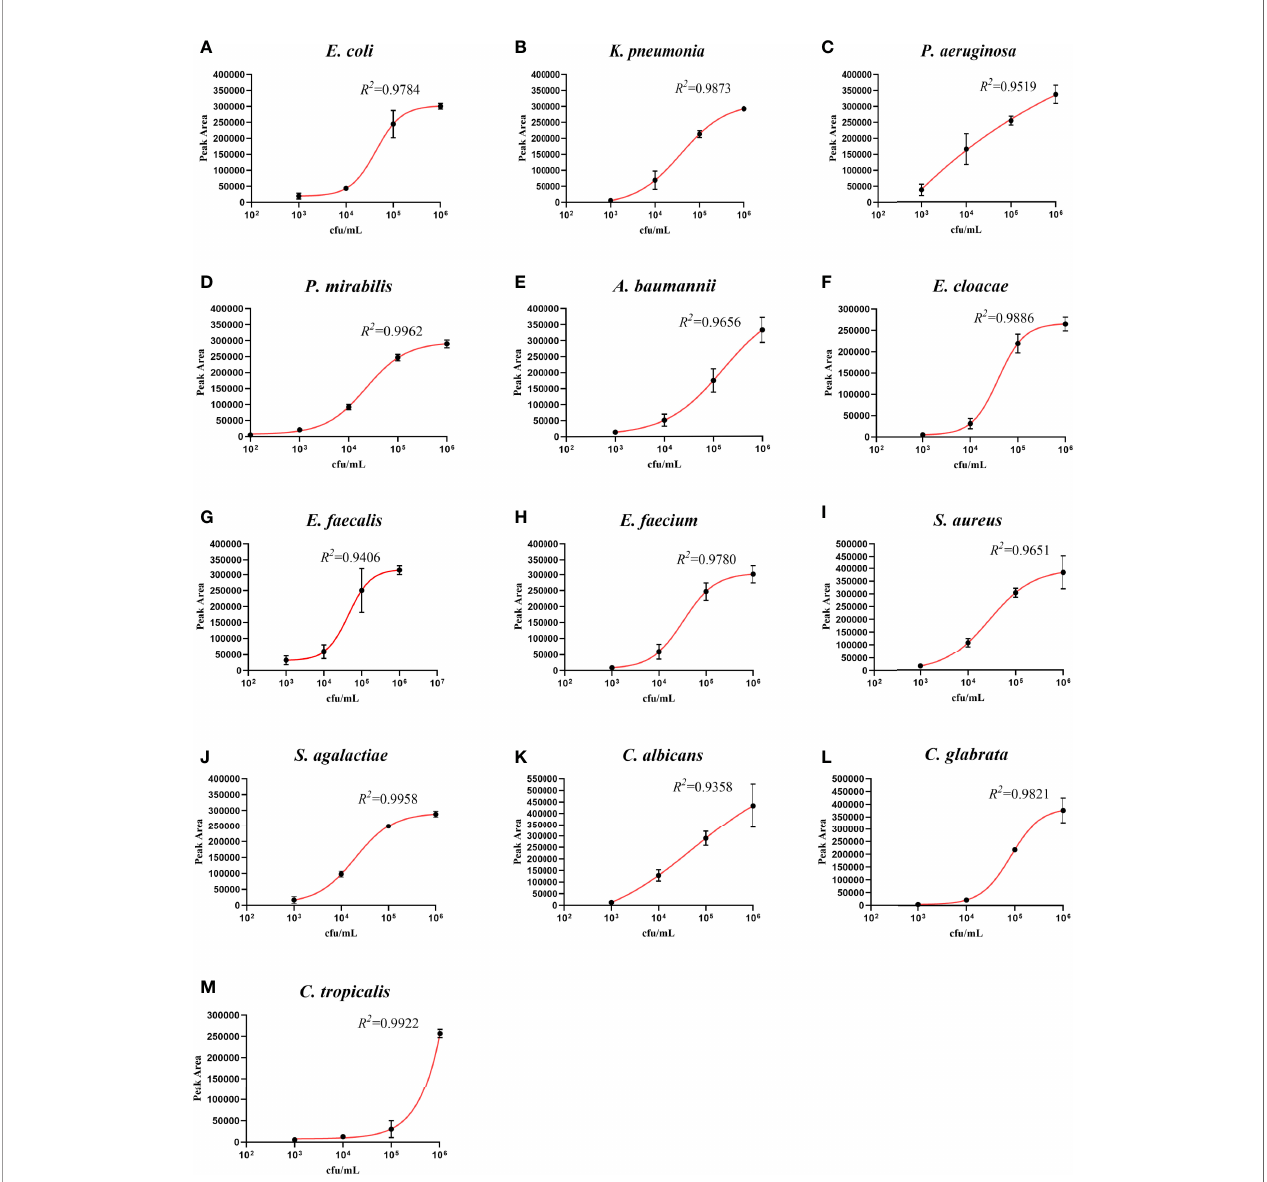
FIGURE 4 | The detection of 13 pathogens in simulated positive urine specimens showing the quantitative standard curves obtained by 10-fold dilutions from 10 2 to 10 6 CFU/mL (x-axis) and their corresponding UTI-HMGS peak area (y-axis). Each concentration was tested on three independent occasions using the UTI-HMGS for all 13 pathogens. Error bars are not shown if they are shorter than the size of the symbol used to indicate the mean value of the three peak areas. (A – M) Calibration curves for E. coli (R 2 = 0.9784), K. pneumoniae (R 2 = 0.9873), P. aeruginosa (R 2 = 0.9519), P. mirabilis (R 2 = 0.9962), A. baumannii (R 2 = 0.9656), E. cloacae (R 2 = 0.9886), E. faecalis (R 2 = 0.9406), E. faecium (R 2 = 0.9780), S. aureus (R 2 = 9651), S. agalactiae (R 2 = 0.9958), C. albicans (R 2 = 0.9358), C. glabrata (R 2 = 0.9821) and C. tropicalis (R 2 = 0.9922),